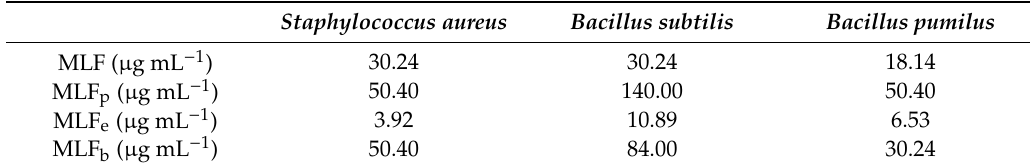
Table 4. MIC of antibacterial activity results of MLF.